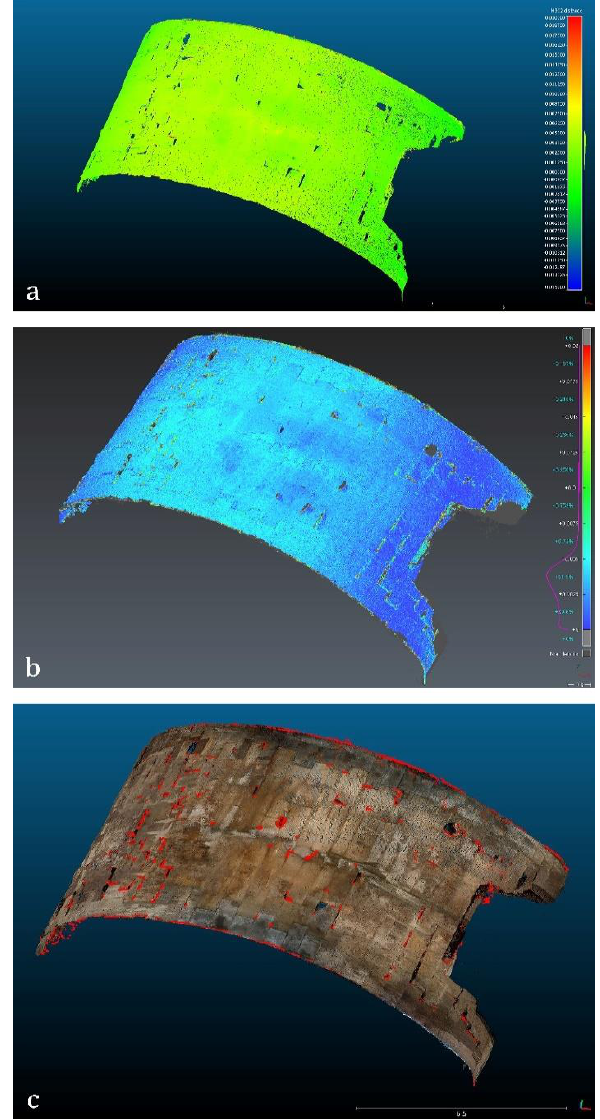
Figure 6. Comparison between TLS and SLR point clouds: a) 3D model with M3C2 distances b) 3D model of